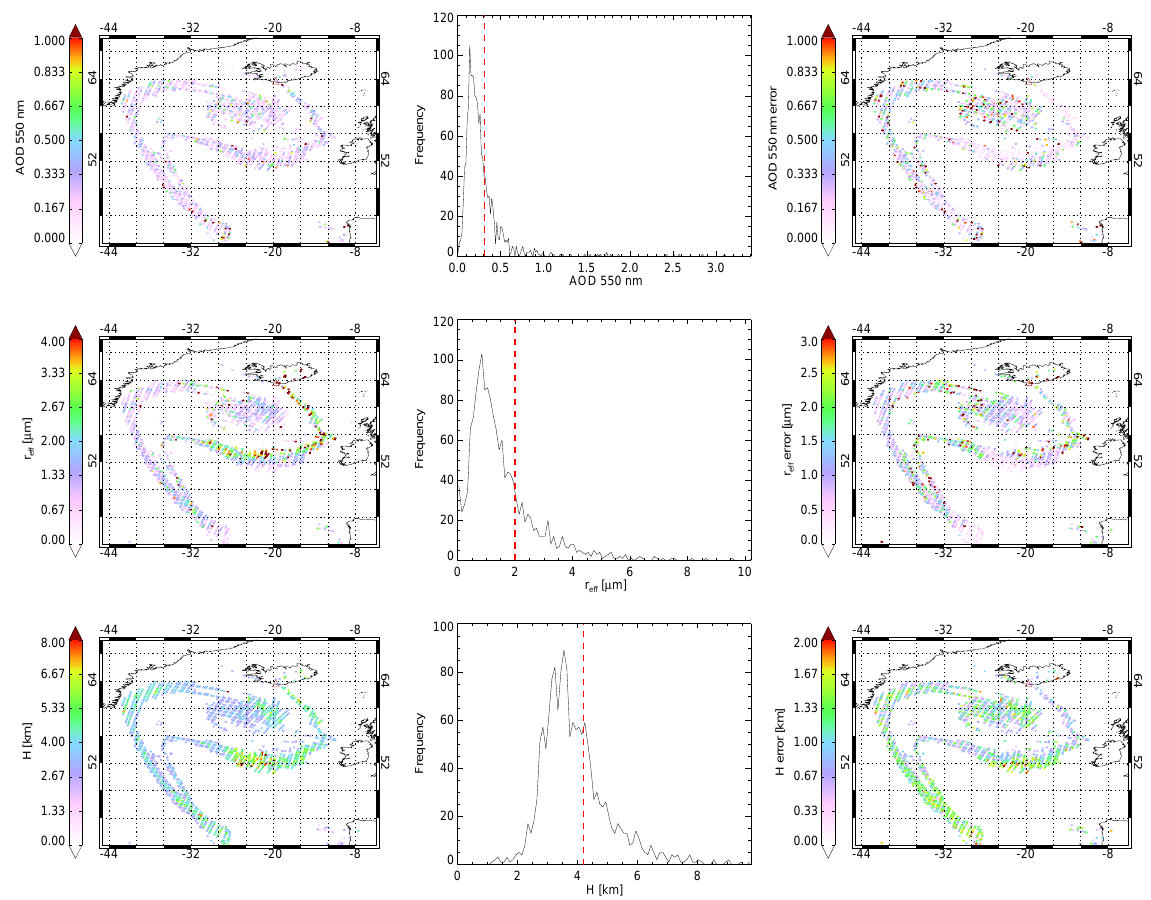
Figure 5. Example retrieval output from 9 May 2010 during the eruption of Eyjafjallajökull. The left-hand column presents the retrieved parameters: ash optical depth, effective radius, and height. The centre column shows a histogram of the respective retrieved values with the a priori value indicated by the red dotted line, and the right-hand column contains the associated uncertainties for each